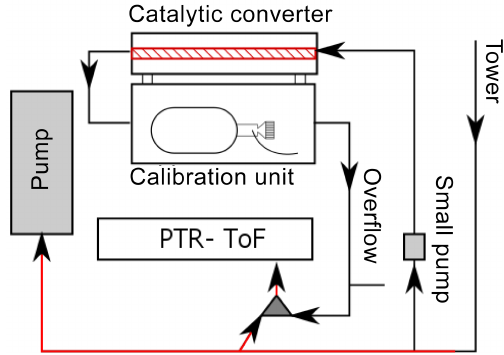
Figure 2. Schematic diagram of the inlet of the PTR-ToF used for the VOC measurements. Red lines indicate heated